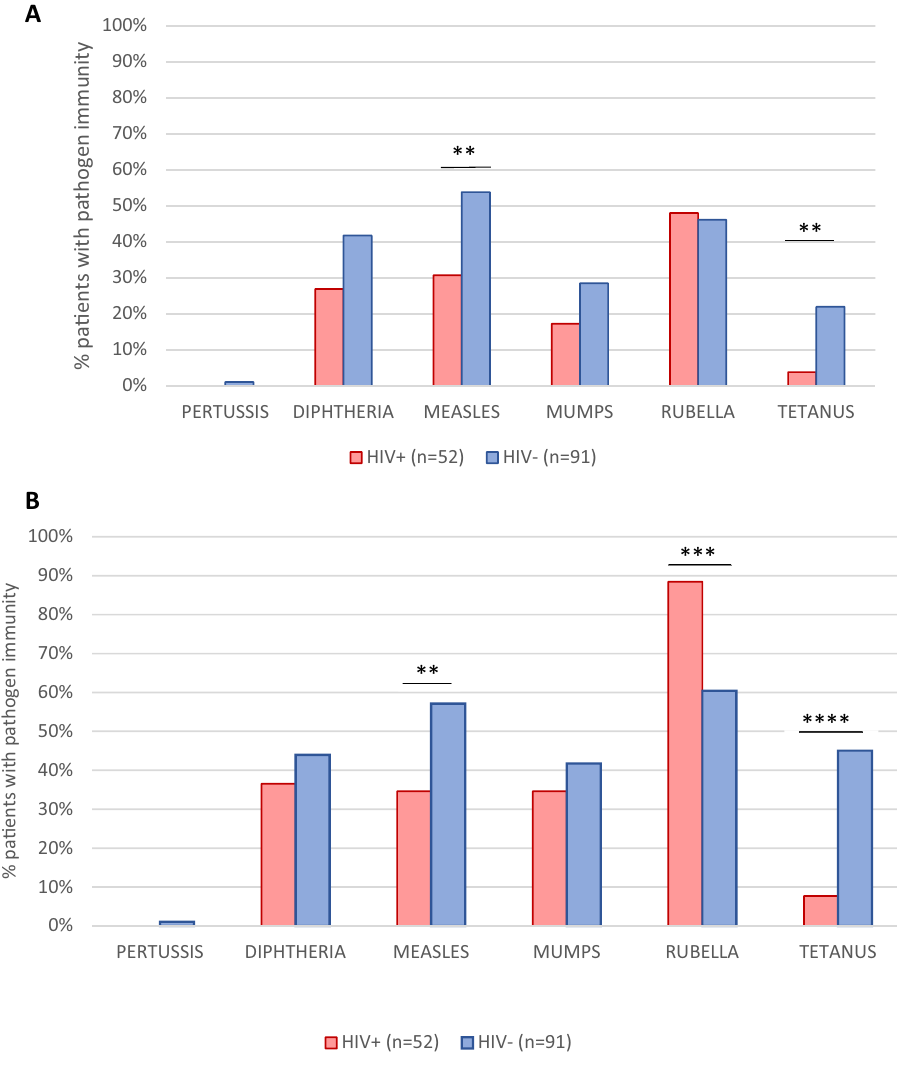
Figure 4. Percentage of patients with pathogen immunity according to the HIV status in 143 children and adolescents using DBS and cut-off of maximum specificity ( A ) and optimal ( B ). HIV+ , HIV-infected patients; HIV−, HIV-uninfected patients; % patients with protective IgG, percentage protection of patients against each of the 6 pathogens according to their reactive IgG levels. With asterisks, statistically significant differences found: ** p = 0.00095, *** p = 0.0004, **** p <